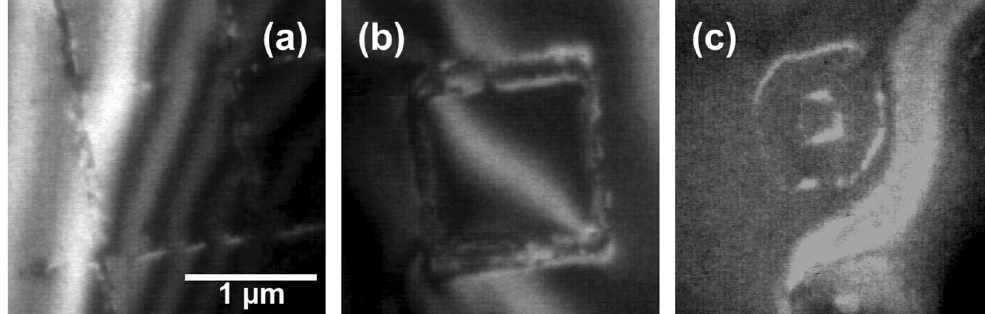
Figure 5. Dark field images of defect structures formed after annealing different implanted patterns. ( a ) a square grid, ( b ) a square and ( c ) a donut shaped structure formed with a defocused beam. A (111) reflection is used for imaging. Si 2 + implantation conditions were 2 × 10 3 ions per nm (~6–7 pA beam current, similar to Fig.